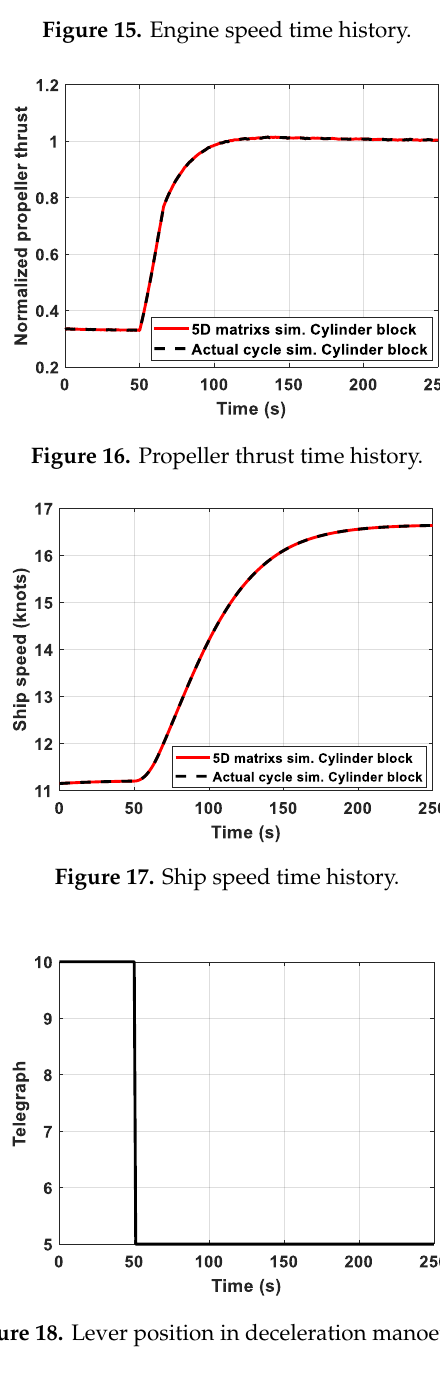
Figure 18. Lever position in deceleration manoeuvre.